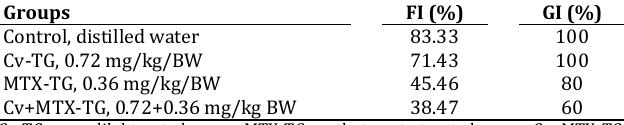
Table 3. Effect of carvedilol alone and in combination with methotrexate on fertility index (FI) and gestation index (GI) of female rats Groups